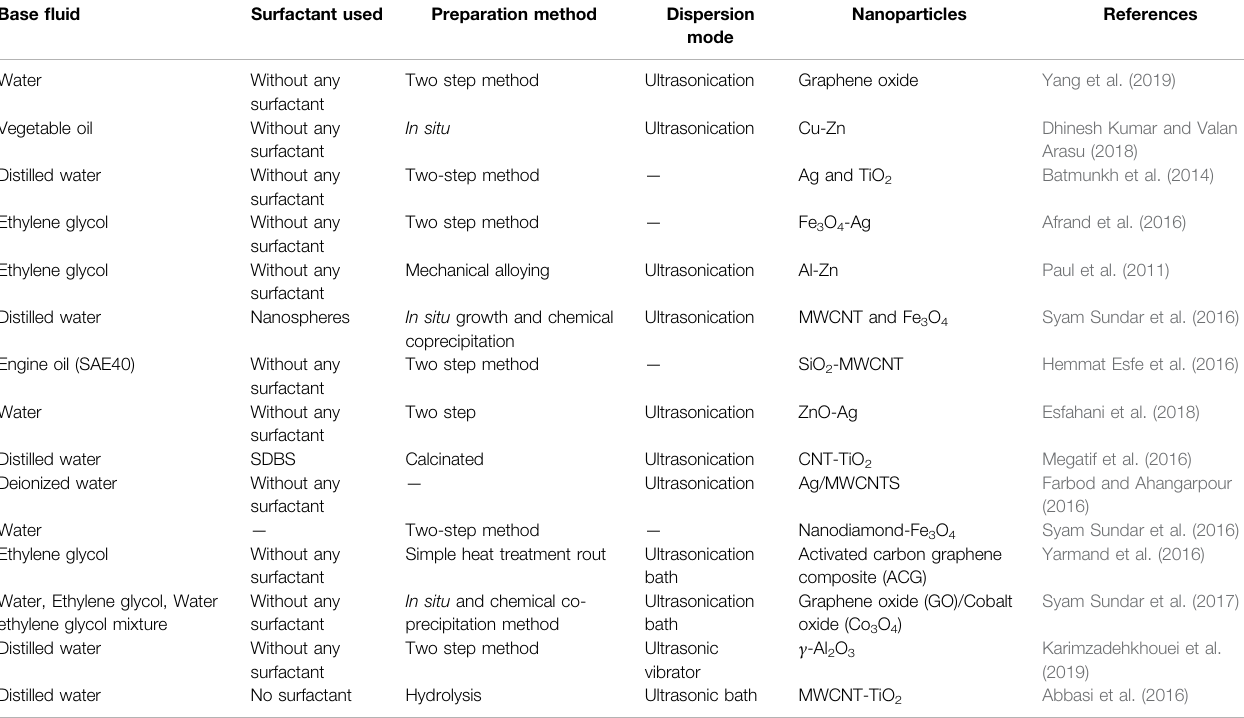
TABLE 1 | Summary of hybrid nano fl uids synthesized using different